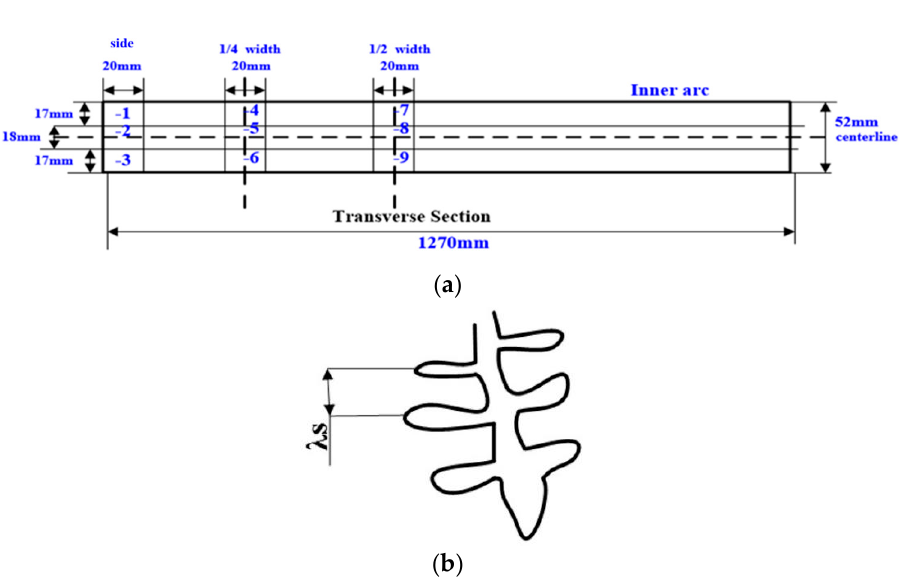
Figure 3. Sampling and measurement: ( a ) sampling for SDAS and EPMA; ( b ) measurement of SDAS.